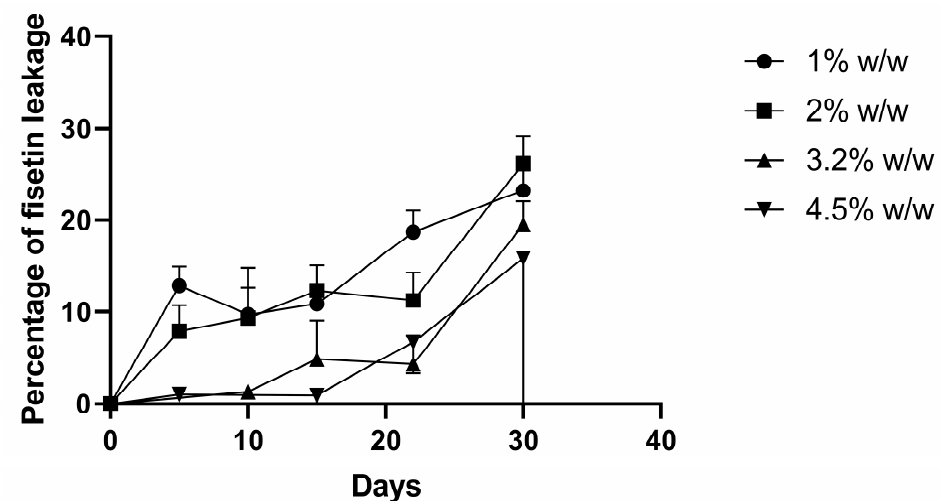
Figure 3. Stability of fisetin-loaded liposomes F4 containing 1, 2, 3.2 or 4.5 wt% of cholesterol (mean ± SD, n = 2). Liposomes were purified using filtration to remove non-encapsulated and precipitated fisetin at each sampling time.